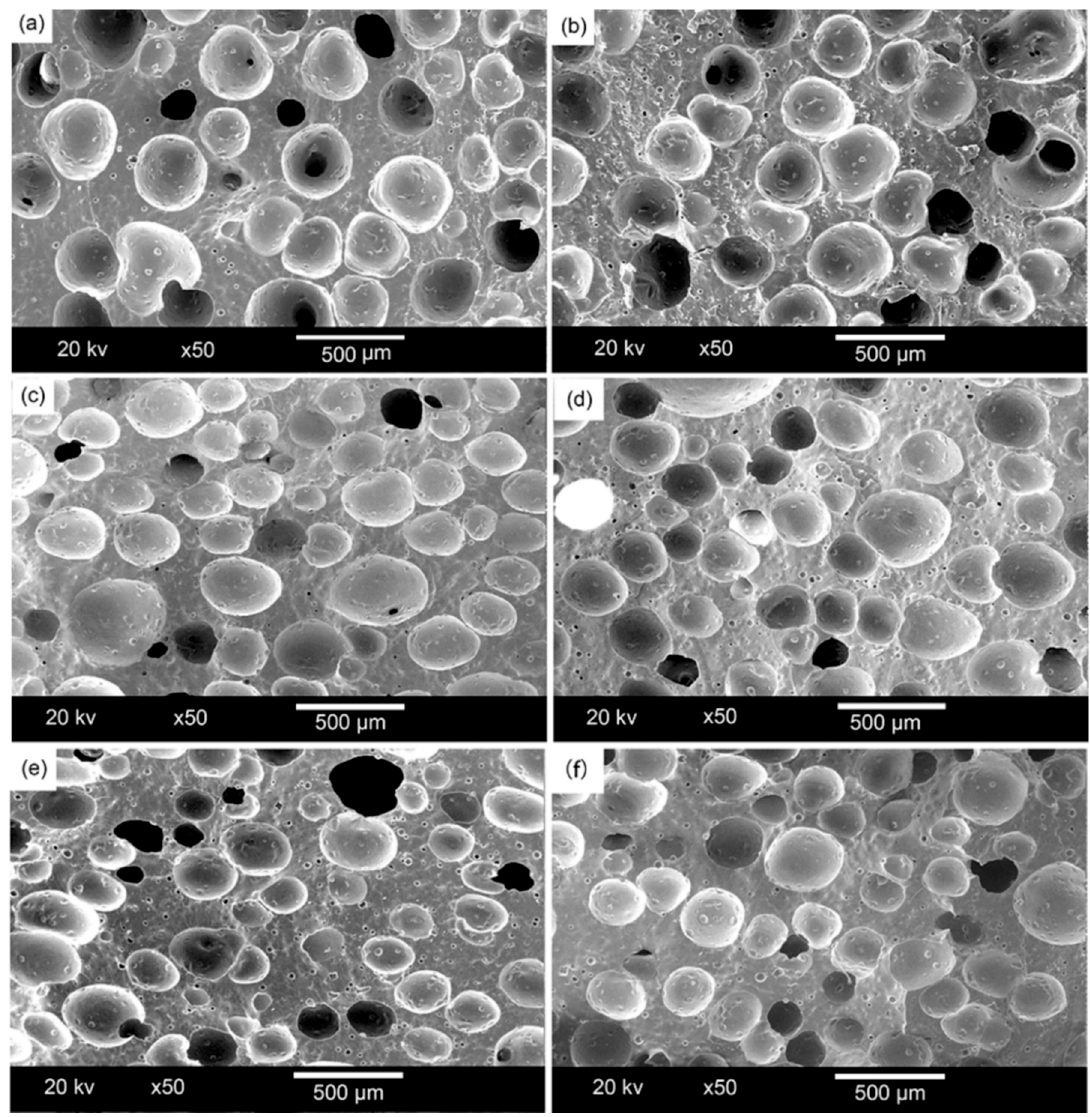
Figure 7. The cell morphology of polysiloxane foam: ( a ) S1, ( b ) S2, ( c ) S3, ( d ) S4, ( e ) S5, and ( f ) S6.